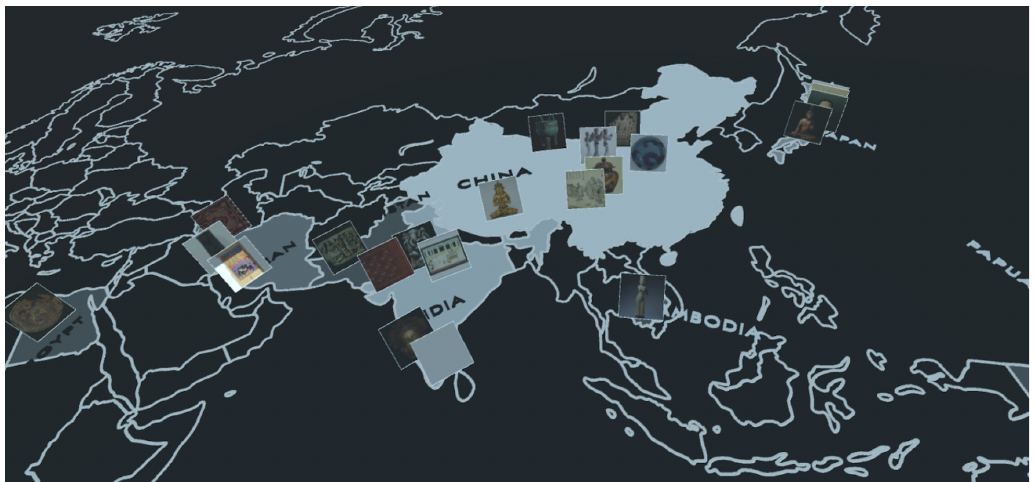
Figure 2. Overview of the entire collection (bird’s eye view perspective) following the “overview first” principle by Shneiderman to let the user gain an overview of the contents of the entire collection. On the subjacent choropleth map layer, countries with large amounts of collection items matching the current filter settings are highlighted. Darker colors mean less instances in the collection.